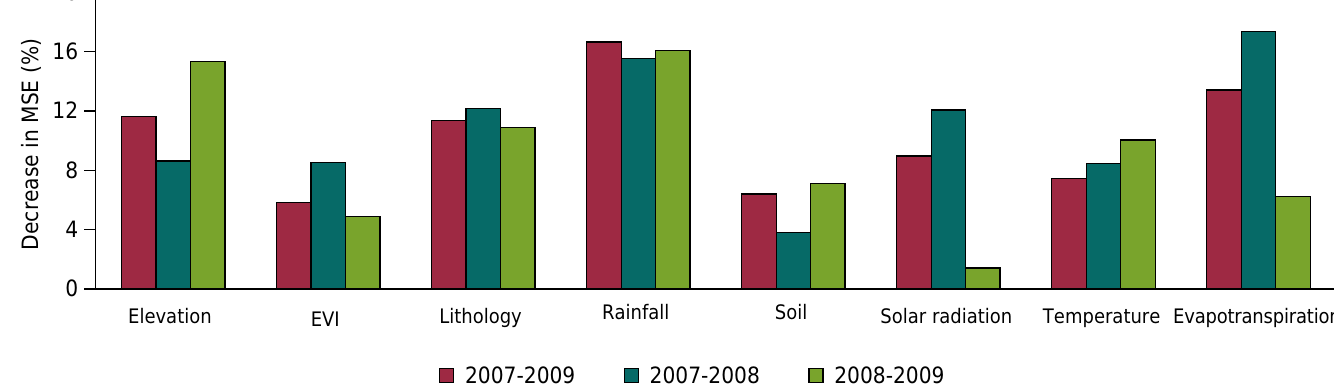
Figure 8. Percentage of covariate contributions in the spatial prediction of groundwater recharge in the Doce River Basin.